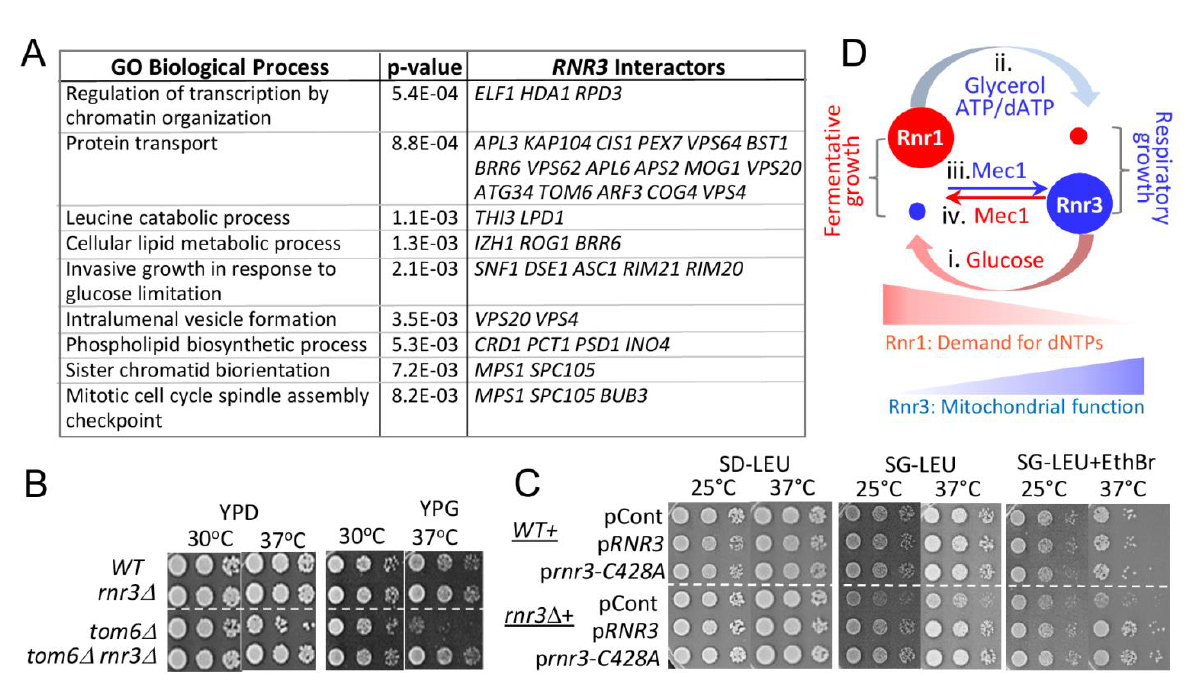
FIGURE 5: Novel genetic interactors unveil a functional link between Rnr3 and mitochondria. ( A ) The SGA database lists 130 genetic in- teractors of RNR3 (Tables S2) [32]. Functional Specification (FunSpec) analysis [39] unveils enrichment of several GO Biological Process terms (Tables S3). (B) Ten fold serial dilutions of the indicated strains were spotted onto YPD or YPG and incubated at the indicated tem- peratures. (C) WT and rnr3  cells transformed with a RNR3-, rnr3-C428A-, or an empty LEU2 vector plasmid were spotted onto SD-LEU, SG- LEU, or SG-LEU plus EthBr (0.5 µg/ml) and incubated at the indicated temperatures. (D) Model: Mec1 and carbon source dependent regula- tion of Rnr1 and Rnr3 facilitates fermentative and respiratory growth. (i) Abundant glucose induces Rnr1 in preparation for rapid prolifera-